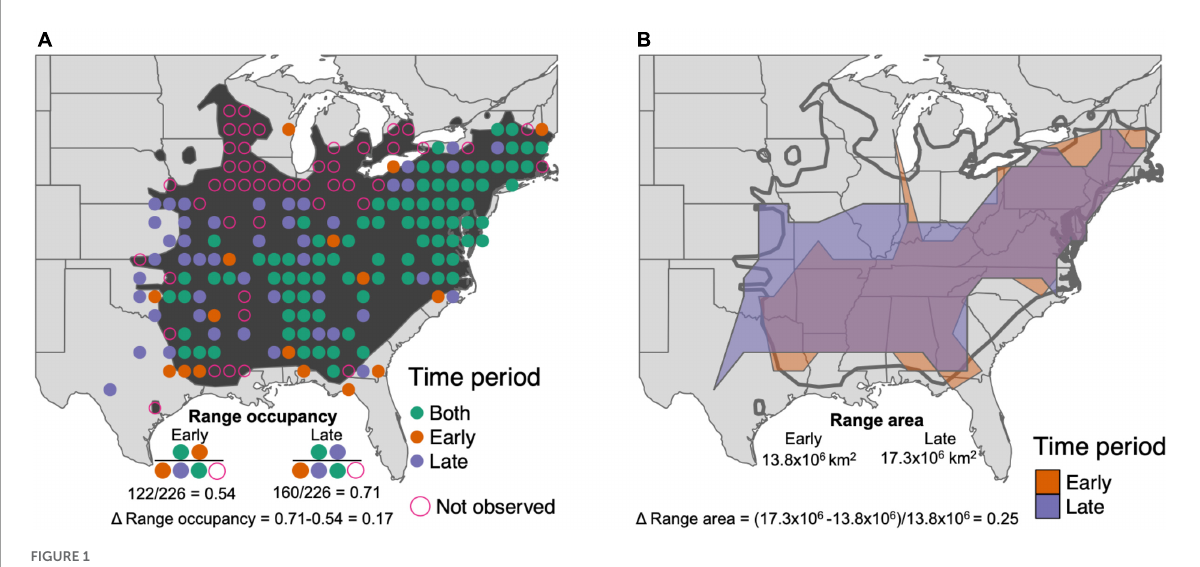
FIGURE1 Measuring changes in the range of Louisiana Waterthrush ( Parkesia motacilla ). (A) Dark shaded polygon shows the breeding range of Louisiana Waterthrush. Circles indicate grid cells with Breeding Bird Survey (BBS) locations. Solid circles indicate locations where Louisiana Waterthrush was observed, in both (green) time periods, just the first time period (orange), or just the later time period (purple). Open pink circles are BBS routes within the breeding range where Louisiana Waterthrush was not observed during either time period. In each time period, the range occupancy of Louisiana Waterthrush is the number of occupied circles over the total number of circles within the breeding range, and the change in range occupancy is the difference between them. (B) Shaded polygons show estimates of Louisiana Waterthrush range area in early (orange) and late (purple) time periods from a concave hull of gridded BBS occurrences. The change in range area is the difference between the later time period area and the early time period area, divided by the early time period area to compare across species with different range sizes. Dark outline shows breeding